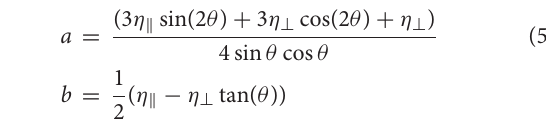
FIGURE 1 | Pictorial view of the geometrical quantities: RLGs versors, the angular rotation vectors, and the main angles. The total angular rotation vector E (cid:127) is the sum of two different vectors E (cid:127) ⊕ , the Earth angular rotation, and E ω . The angles are positive with the convention expressed by the small arrows, n 2 is vertical). The versors of the two RLGs, n 1 and and the RL 2 is horizontal ( ˆ ˆ n 2 are shown with thicker lines, the main angles ζ , γ , α , and ξ are shown, the ˆ ω and angle α is the angle between E (cid:127) and E (cid:127) , while ξ is the angle between E ⊕ E (cid:127) ⊕ . Adapted from Tartaglia et al. (2017) under the Creative Commons CCBY